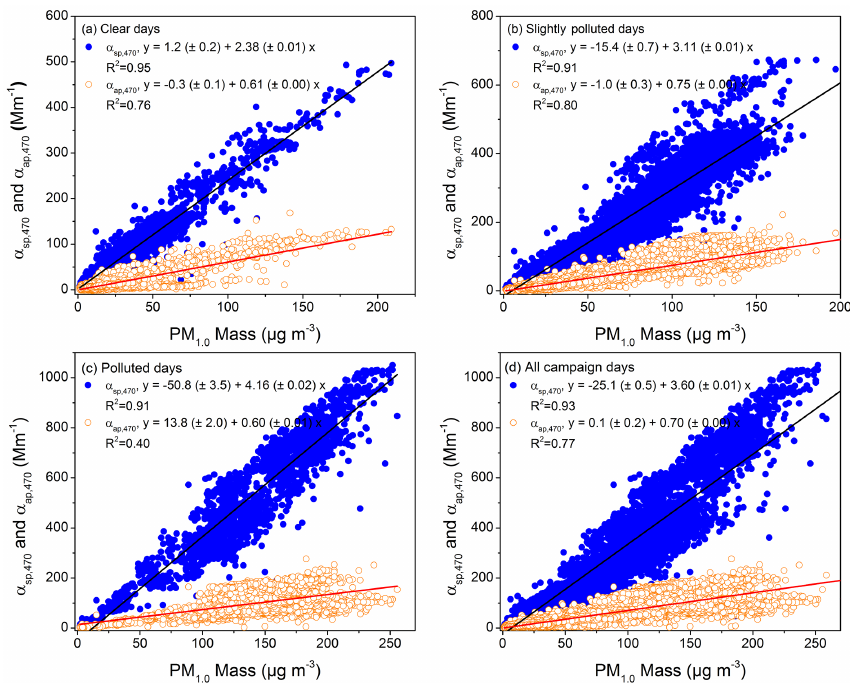
Figure 6. Scatter plots of the measured scattering and absorption coefficients at λ = 470nm against PM 1 . 0 mass concentrations for PM 1 . 0 particles under different pollution